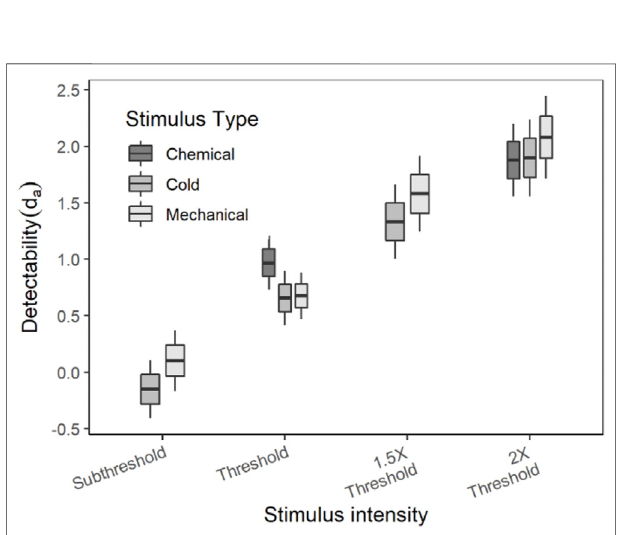
FIGURE 3 | Comparison of d a between stimulus intensities and stimulus types.